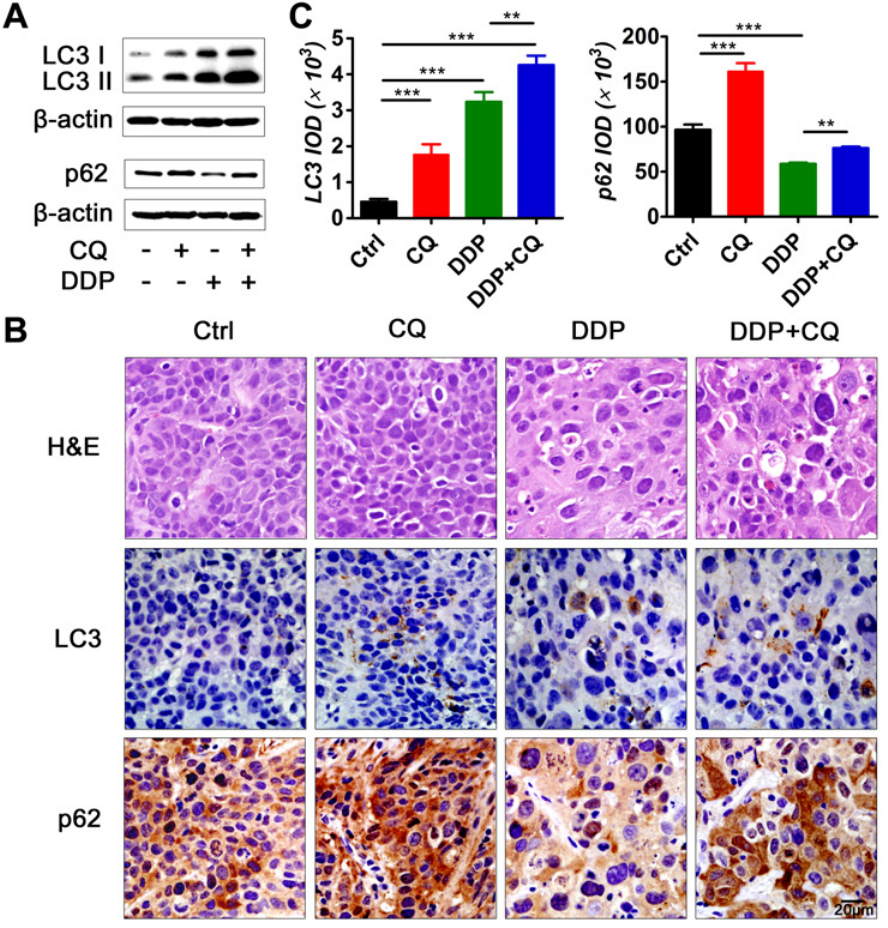
Fig 2. Inhibition of autophagy by CQ and induction of autophagy by DDP in vivo . Tumor tissues were harvested for autophagy analysis after treatment for 18 days. (A) Western blot analysis of autophagy markers LC3 and p62. (B) Representative micrographs of tumor sections: hematoxylin and eosin (H&E) stain (upper panel) and immunohistochemistry (IHC) for LC3 (middle panel) and p62 (lower panel). Scale bar = 20 μ m. (C) Quantification of LC3 expression (left) and p62 expression (right) according to the Integrated Optical Density (IOD) ( ** p < 0.01, *** p < 0.001).